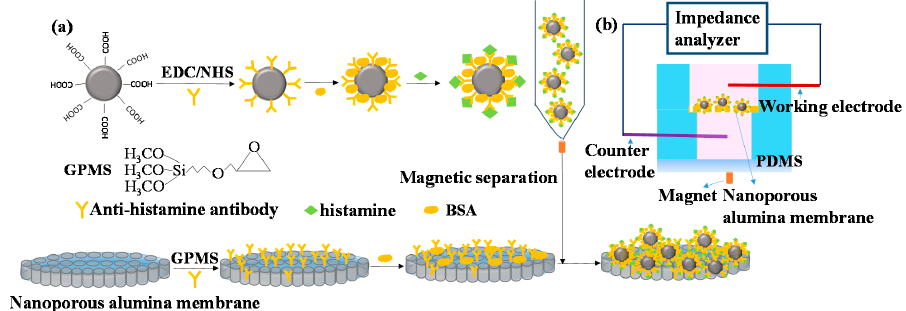
Figure 2. Schematic diagram of biofunctionalization of magnetic nanoparticles (MNPs) for histamine concentration to nanoporous alumina membrane ( a ) with electrochemical biosensing system for detection ( b ). EDC, N -(3-Dimethylaminopropyl)- N -ethylcarbodiimide hydrochloride; NHS, N -Hydroxysuccinimide; BSA, bovine serum albumin; PDMS, polydimethylsiloxane .